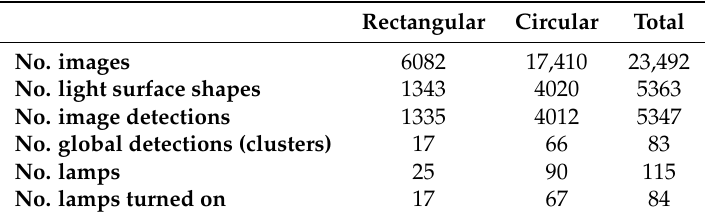
Table 2. Statistics of the dataset and the spaces used for the